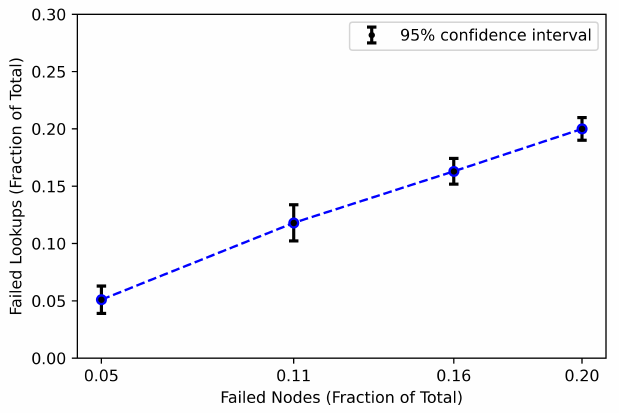
Figure 11. The fraction of lookups that fail as a function of the fraction of nodes that